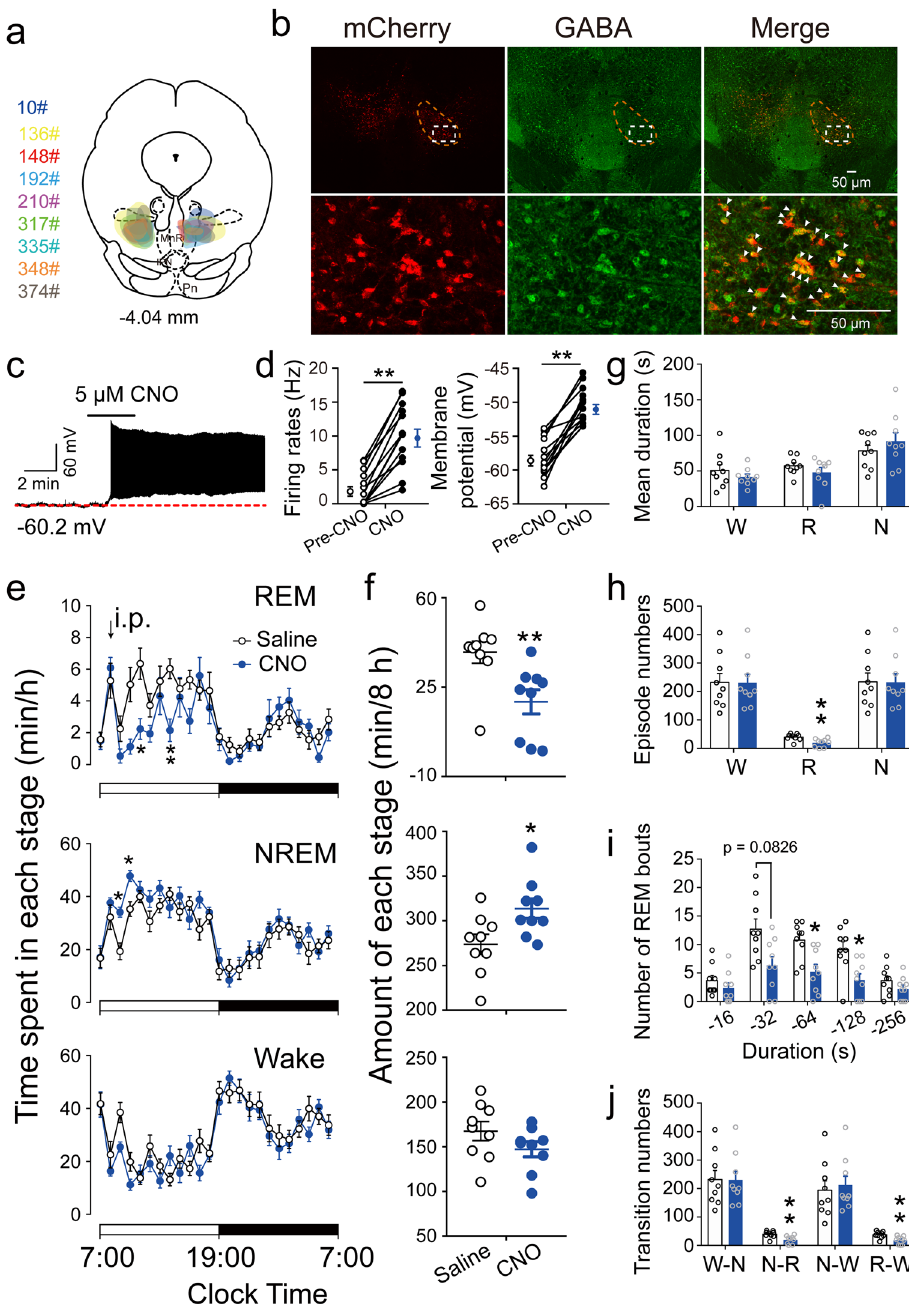
Fig.1|ChemogeneticactivationofRMTgGABAergicneuronssuppressedREM sleep. a A coronal section shows the superimposed injection sites of adeno- associated virus (AAV) encoding hM3Dq fused to an enhanced red fl uorescent protein (mCherry) reporter into the bilateral RMTg in nine VGAT-Cre mice. b Representative photomicrographs of RMTg GABAergic neurons from a mouse microinjected with AAV vectors encoding hM3Dq. The mCherry (red) and GABA- immunolabeling (green) indicate hM3Dq- and GABA-expressing neurons, respec- tively, and the yellow image depicts merged neurons. Top: lower magni fi cation of theimages.ThedashedcircleareashowsthelocationoftheRMTg.Bottom:higher magni fi cation of the dashed square region in the top corresponding images. c A typical trace recorded from an hM3Dq + neuron in the RMTg during appication of Clozapine-N-oxide (CNO). d CNO signi fi cantly increased the fi ring rates ( T 12 =8.446, p <0.0001)andmembranepotential( T 12 =9.217, p <0.0001)ofRMTg hM3Dq-expressing neurons ( N =13 cells from 5 mice). e , f After administration of